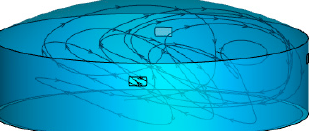
Figure 9. Streamtraces inside and outside the tank. The diffusion of the n-hexane vapors evaporating from the tank was greatly affected by the ambient wind. In the numerical simulation, the ambient wind was set along the X-axis, and the wind speeds in the inlet were set to 4.36 and 6.36 m·s − 1 , respectively. The velocity-contour distributions both inside and outside the IFRT in the XY plane are depicted in Figures 10 and 11. The results demonstrate that the airflow was obstructed by the tank at the windward side and that the velocity of the airflow was gradually reduced from 4.36 to 0 m·s − 1 . Combined with the pressure-cloud diagram at the windward side of the tank wall in Figure 12, it can be concluded that the pressure on the windward side of the tank body increased because the wind speed translated into stagnation pressure. On the surface of the tank roof, the flow cross-section of the ambient wind shrunk, causing a sudden increase in the wind speed and negative pressure (see Figure 13). The wind speed near the tank roof exceeded the ambient wind speed, and the maximum wind-speed value reached 5.5 and 8.0 m·s − 1 , respectively. On the leeward side of the tank wall, the wind-speed iso-surface continuously shrunk toward the bottom of the tank because of the obstruction of the tank body (see Figures 10 and 11). The minimum value of the wind speed was approximately 0 m·s − 1 at the bottom of the leeward side of the tank wall. Compared to the windward side, the region of lower wind speed was larger in the leeward side. Combined with the wind-flow diagram of the inside and outside of the tank (see Figure 9) and the tank-wall pressure-cloud diagram on the leeward side of the tank (see Figure 13), it can be seen that negative pressure and vortexes appeared near the leeward side of the tank. Figure 10. Velocity distribution of the IFRT under the ambient wind speed of 4.36 m·s − 1 .